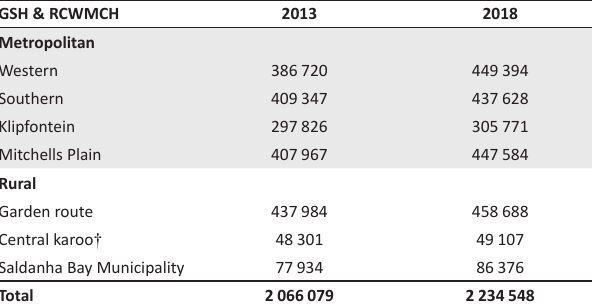
TABLE 2a: Western Cape Province Drainage populations 2013 and 2018 (dependent).